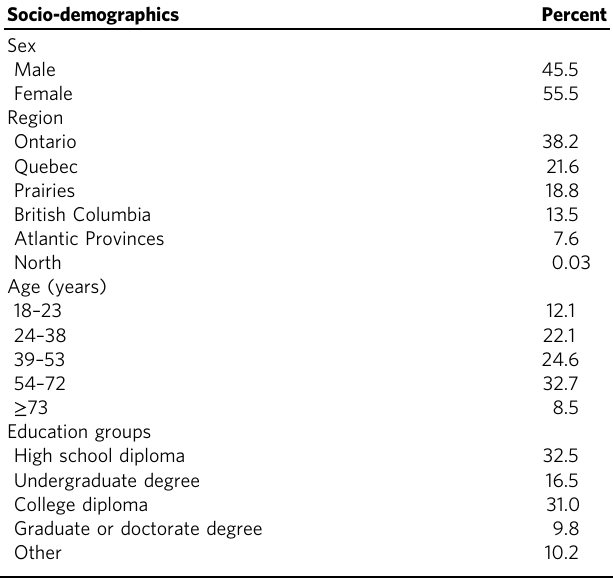
Table 1 Socio-demographic characteristics of respondents.